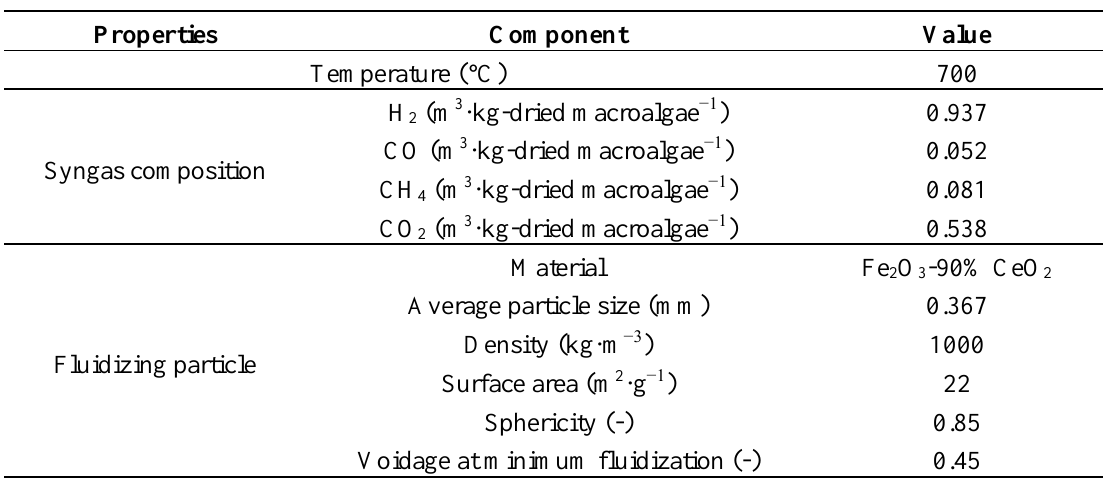
Table 3. Assumed gasification conditions used during calculation including syngas composition and fluidizing particles inside the